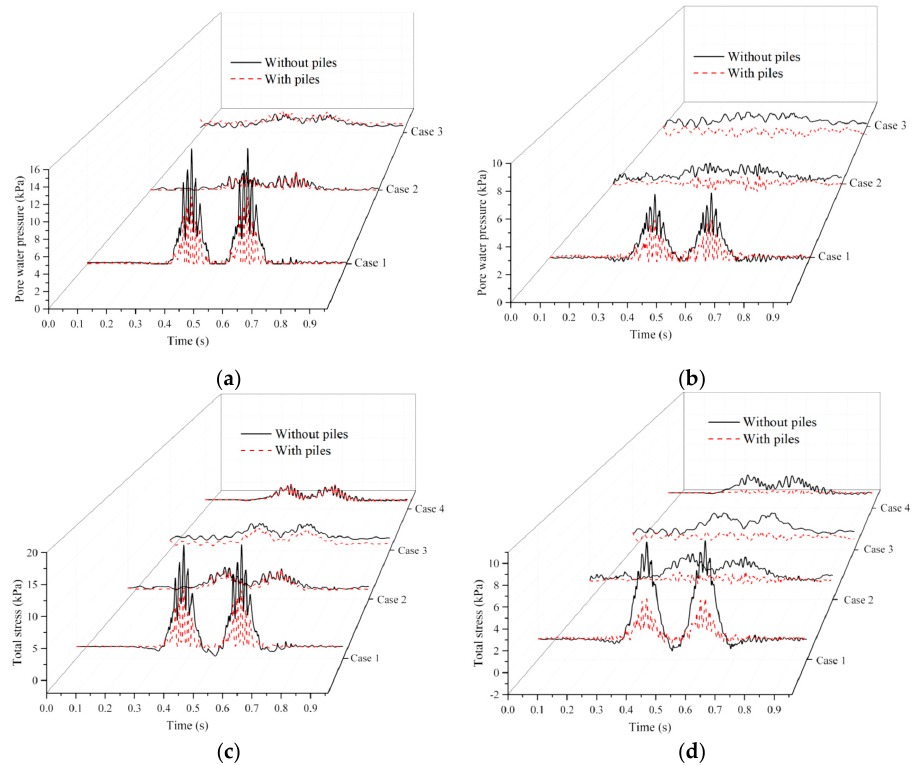
Figure 12. Time history curves of vibration responses: ( a ) Pore water pressure at the surface of the first layer of ground, ( b ) pore water pressure at the surface of the second layer of ground, ( c ) total stress at the surface of the first layer of ground, and ( d ) total stress at the surface of the second layer of ground.